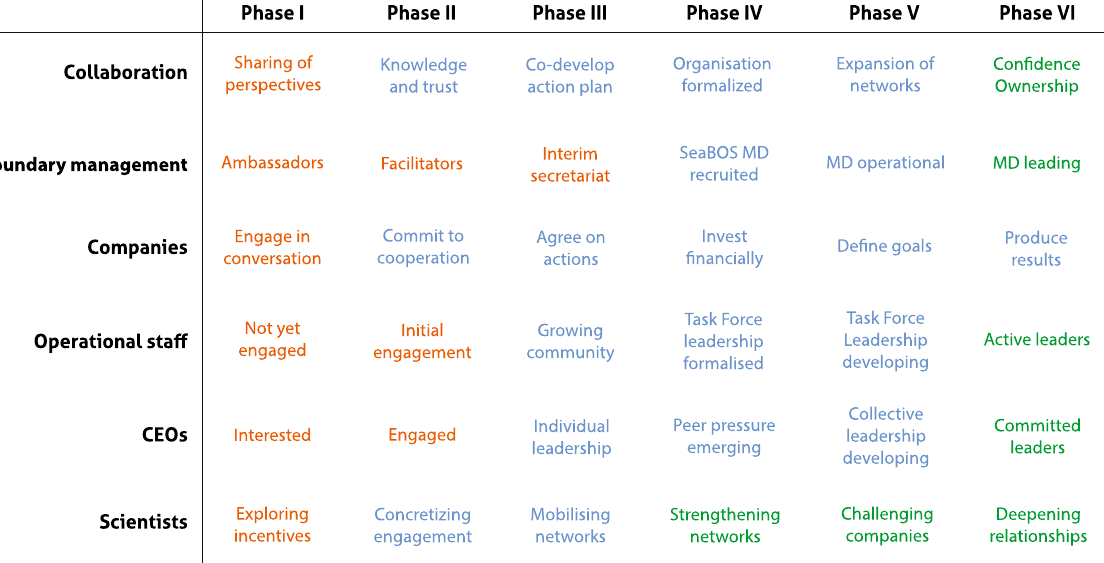
Figure 4. Evolutionary components of science-business cooperation. Colour coding of different components and actors engaged in collaboration, representing a qualitative assessment of the evolution of cooperation from an early and unstable phase, to operational, stabilised and functional cooperation. Colours refer to: insufficient, short term and vulnerable (orange); positive developments and long-term commitments, but not stable (blue); Adequate and resilient (green). MD managing